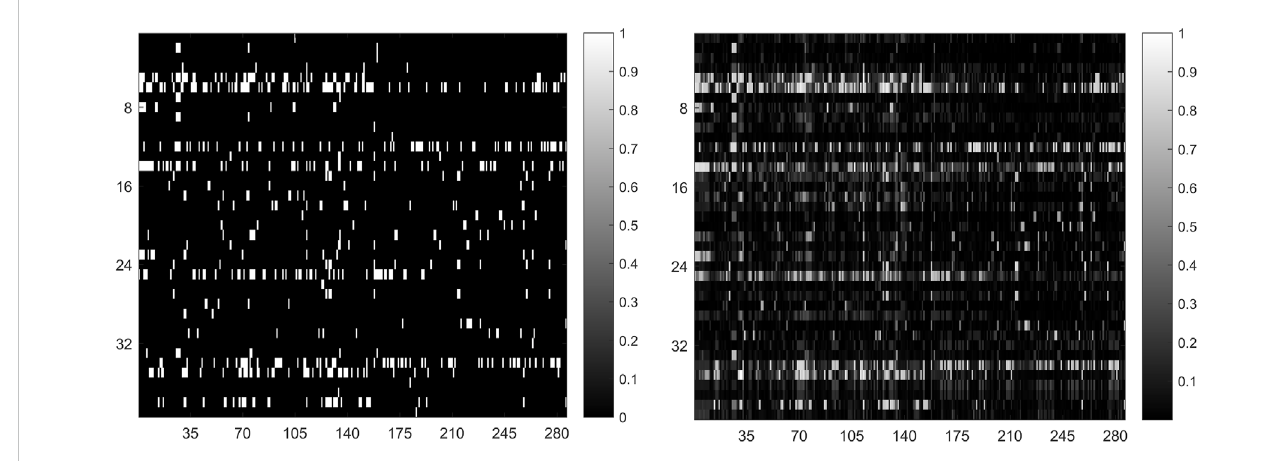
FIGURE 3 The comparison of original association adjacency matrix (left) and the prediction association matrix